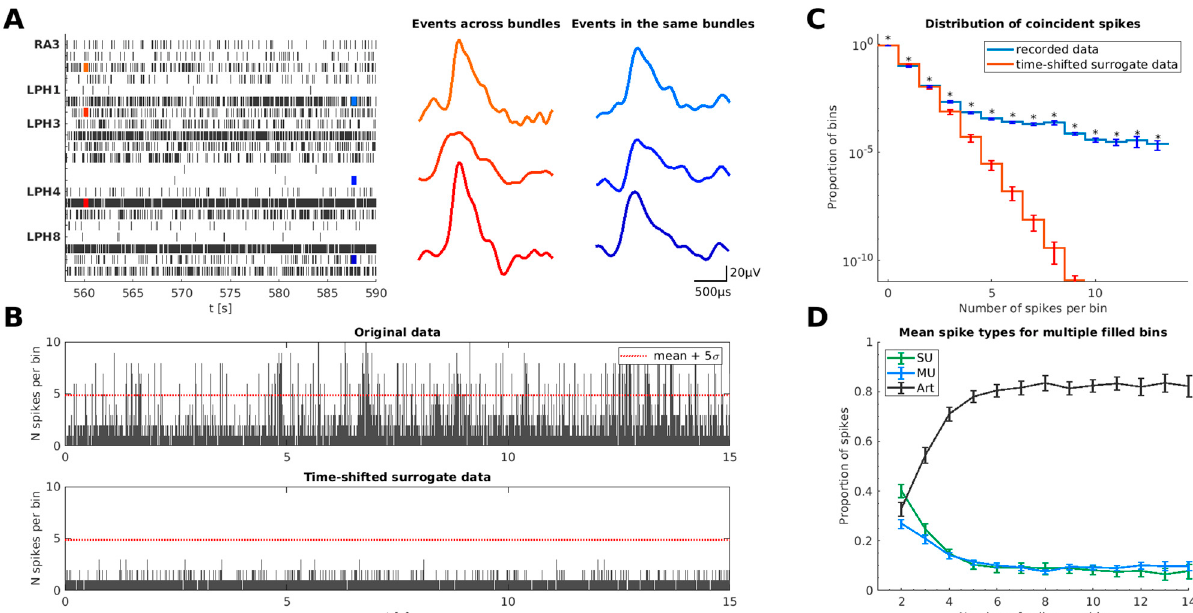
Figure 1. Characteristics of duplicate spike events in human microwire recordings. ( A ) Raster plot of units recorded from 5 microwires located in the right amygdala (RA) and the left posterior hippocampus (LPH). Red and blue lines indicate the timing of simultaneous spike-event shapes drawn next to the raster plot. The three red-shaded spike events occurred simultaneously across bundles while the three blue-shaded events occurred within the same bundle (left hippocampus); ( B ) Binned spike counts of a typical 15 s segment of data. Within each 0.5 ms time bin, the number of spike events across all 80 recording channels was counted. The red dotted horizontal line indicates the mean plus 5 standard deviations ( σ ) of all bin counts. A substantial fraction of time bins exceeds this 5 σ -threshold, indicating a high proportion of simultaneous spike events. The lower panel displays a 15 s segment from the same recording session based on randomly circular time-shifted data for each cluster. In this time-shifted surrogate data, no bin count exceeded the 5 σ -threshold of the original data. The y -axis is limited to 10 for better visualization; ( C ) Distribution of bins filled with different numbers of spike events across all 51 recording sessions. The blue curve shows the proportion of bins in the original recorded data, indicating a considerable number of bins with 5 and more spikes. The red curve shows the distribution for time-shifted surrogate data of all 51 recordings (1000 permutations, Wilcoxon signed-rank test, N = 51, p < 0.0036); ( D ) Distribution of spike-event types in filled bins. Spike events in bins with several spikes most frequently originated from artifact clusters. However, some of these events were also found in SU (single units) and MU (multi-unit) clusters ( x -axis limited to 14 for which more than half of recordings contributed with at least 10 bins).